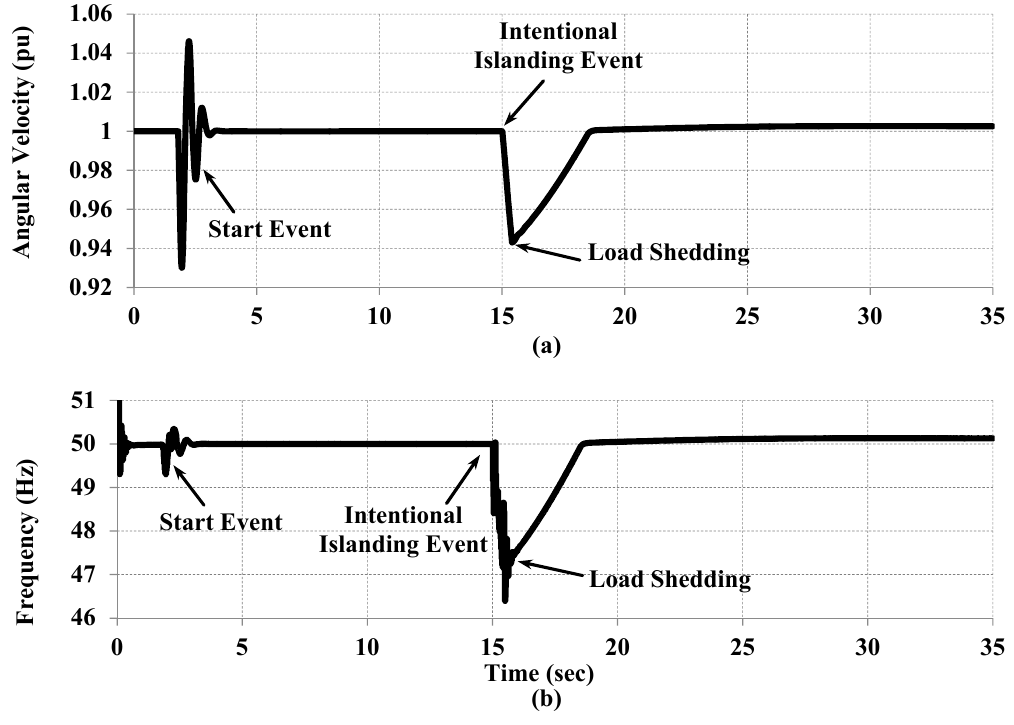
Figure 15. System parameters ( a ) synchronous generator angular velocity, ( b ) island-2 frequency.